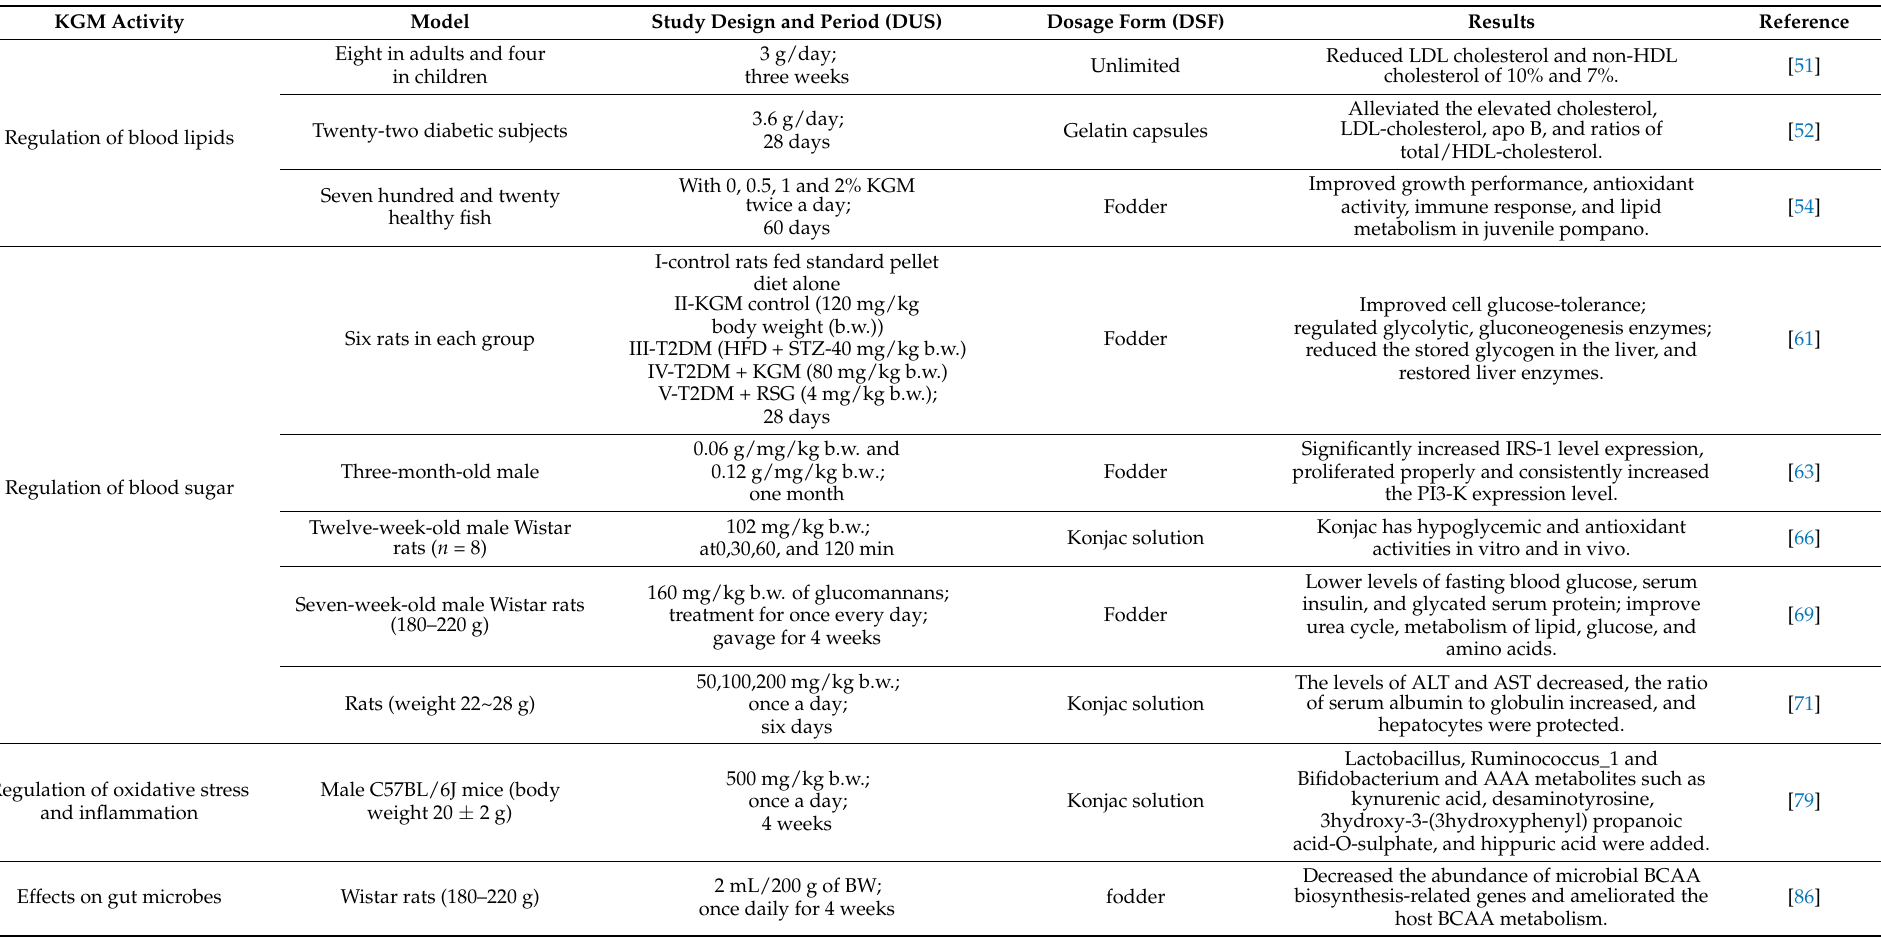
Table 1. Summary of biomedical functions of diabetes mellitus by